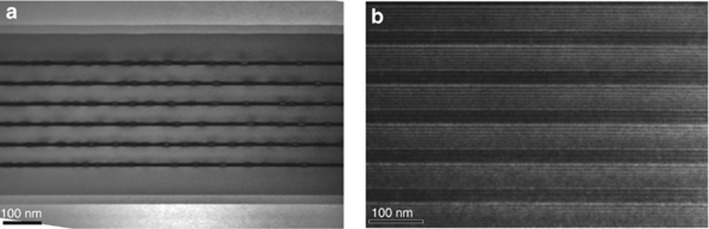
Cross-sectional transmission electron microscopic images of (a) the multiple InAs/GaAs quantum dot active layer structure and (b) the In0.678Ga0.322As/In0.365Al0.635As quantum well cascade active layer structure.